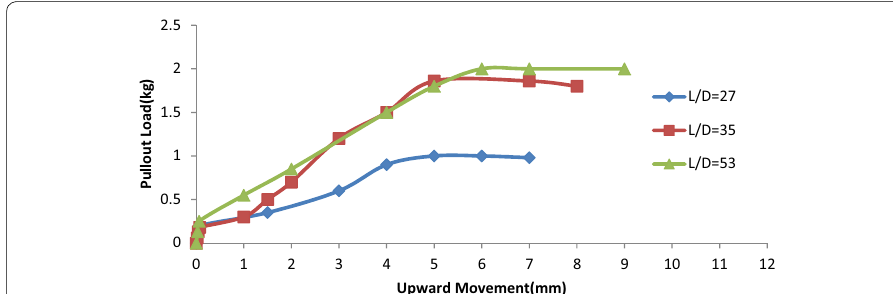
Fig. 14 Pullout load-upward movement curves for steel pile without helix